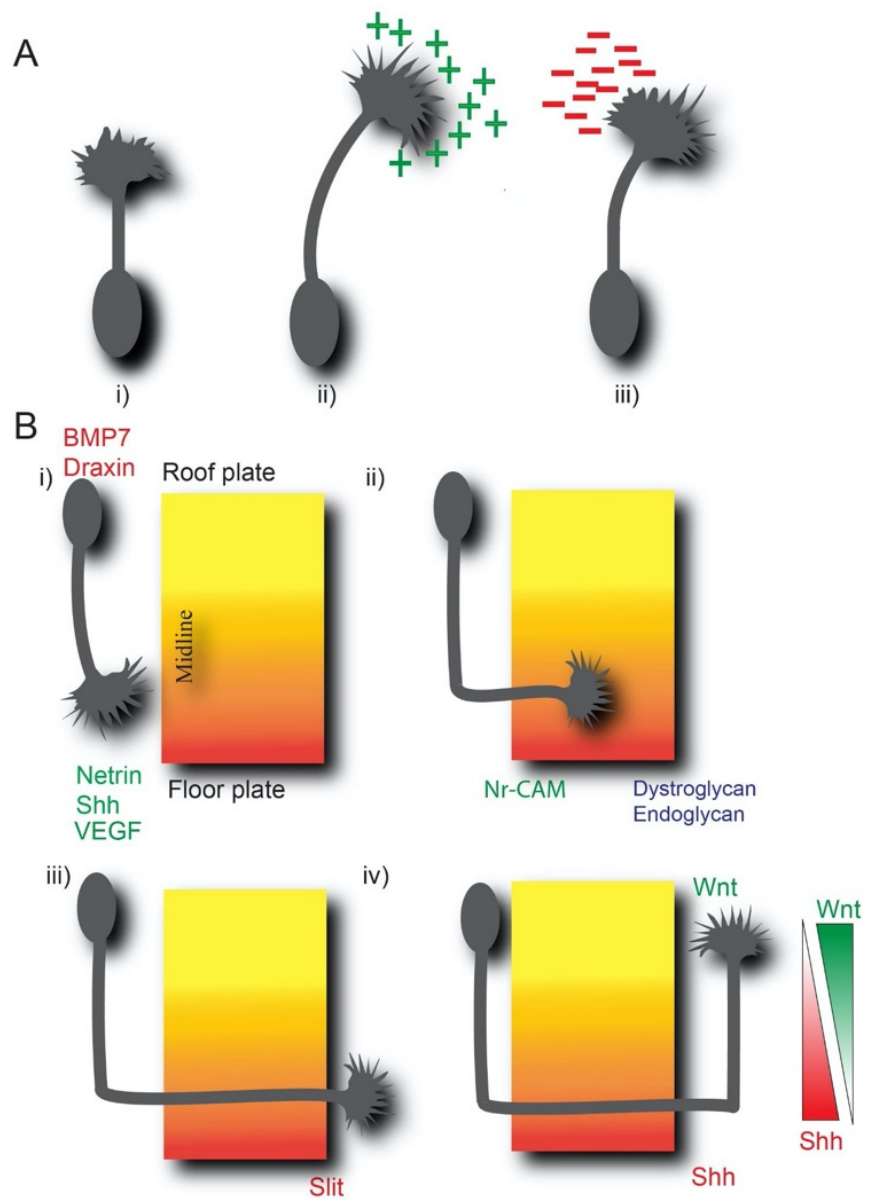
Figure 1. Overview of axonal guidance. ( A ) Growth cone (i) extends and turns toward the attractive cues like netrin, shh (ii) and repelled by repulsive cues like slits, semaphorins (iii). Attractive and repulsive cues are shown with + (green) and –(red), respectively. ( B ) Short-range and long-range guidance within the spinal cord. (i) Axons are repelled by BMP7 and draxin from the roof plate. Shh and netrin-1 attract axons toward the floor plate by long-range attraction. Netrin-1 produced by neural progenitor cells has also been proposed to guide commissural axons locally (not shown here) while whether floor plate netrin is dispensable or not is debated [9]. (ii) Axons enter the floor plate through short-range guidance, for example, through Nr-CAM. (iii) Slit allows axons to exit the floor plate. (iv) Axons move rostrally through the repulsive gradient of Shh (acts as an attractive cue pre- crossing and repulsive cue post-crossing) and attractive gradient of Wnt. Examples of glycosylated proteins regulating adhesion at the midline are shown (dystroglycan, and endoglycan). Receptors and multiple other guidance cues e.g., semaphorins involved in regulating midline crossing that are beyond the scope of this review are not shown